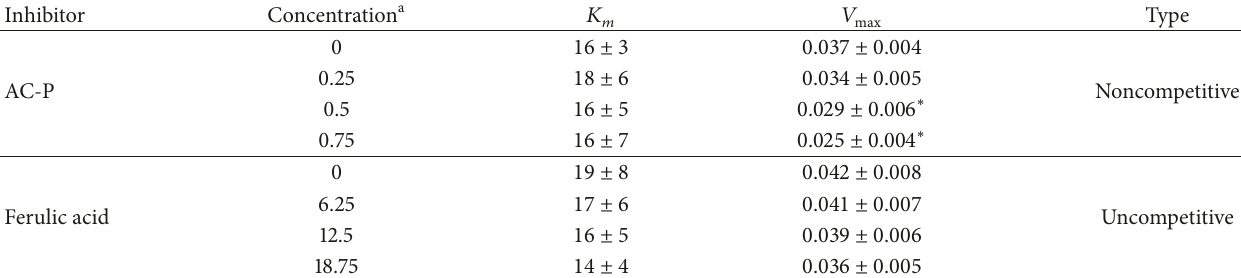
Table 4: Values of 𝐾 𝑚 and 𝑉 max for uric acid production catalyzed by XO in the presence of AC-P and ferulic acid.